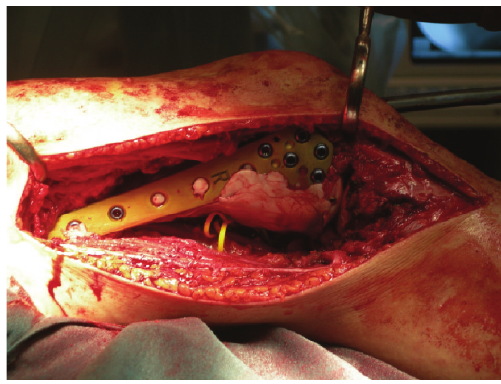
Figure 5: The plate, cement, and screws used to reconstruct the bone defect.